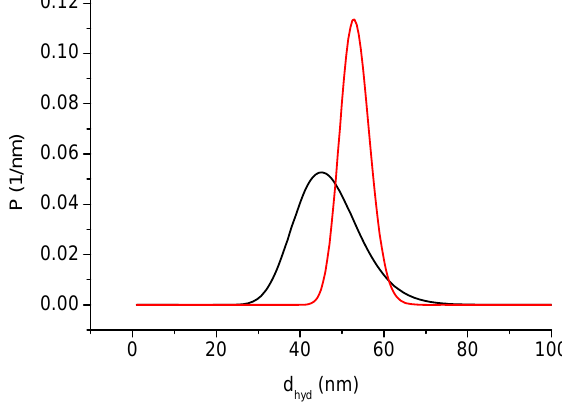
Figure 3. Size distributions of the original DDM128N (black) and the largest fraction (red).